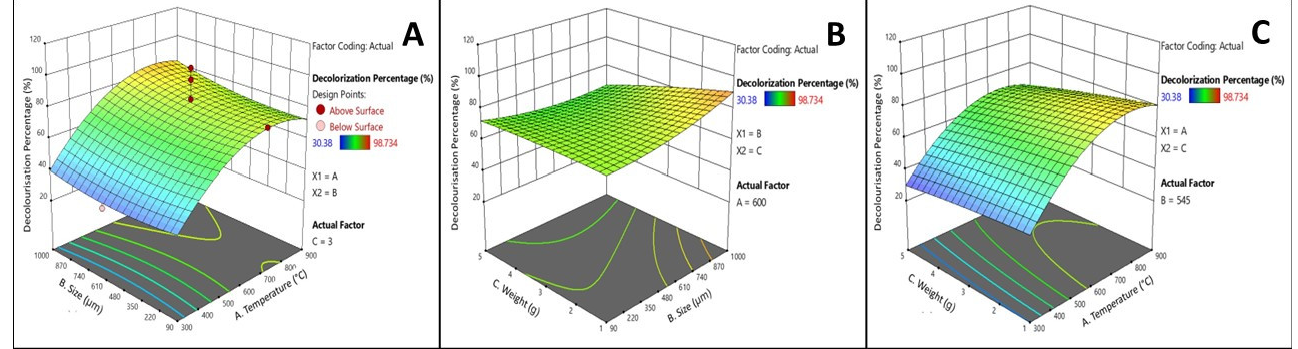
Figure 4. Response–surface curve (3-D plot) of dye decolourisation of RTDW showing the interaction between ( A ) temperature vs size, ( B ) size vs weight and ( C ) temperature vs weight.